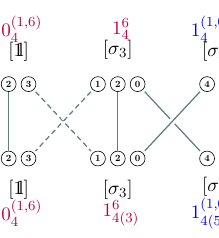
Figure 4 . T -duality chain of the E(xotic)-branes.